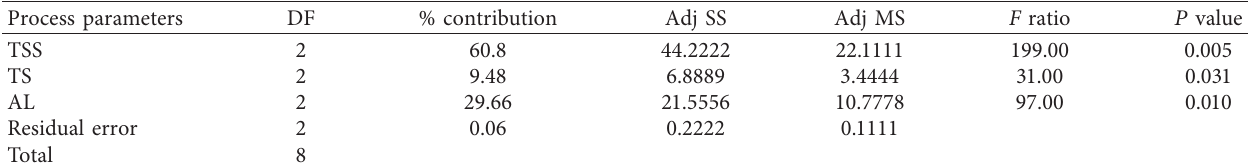
Table 8: ANOVA outcomes for